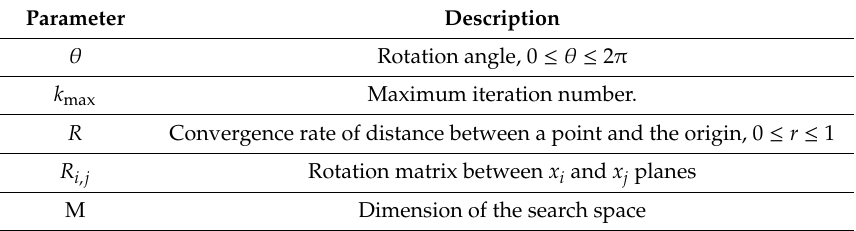
Table 3. Spiral dynamic algorithm (SDA) optimization